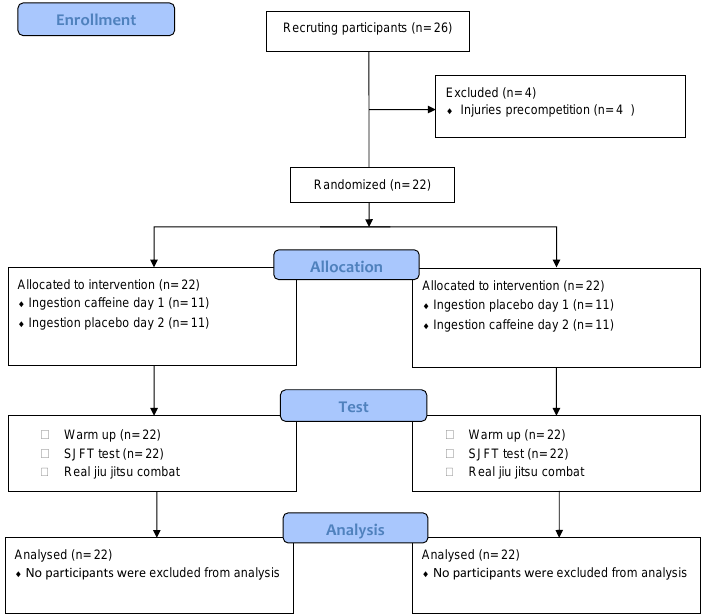
Figure 1. CONSORT flow diagram of methodology and data analysis.